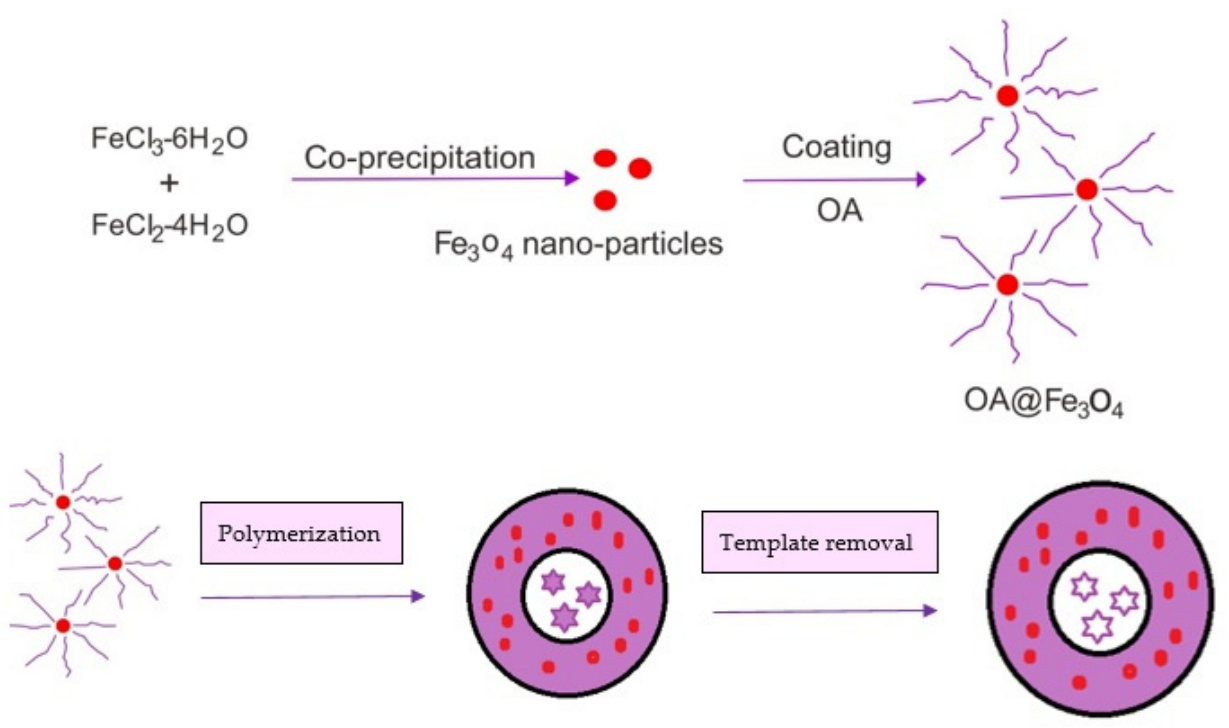
Figure 2. Scheme for the preparation of MMIPs with an oleic acid topcoat.